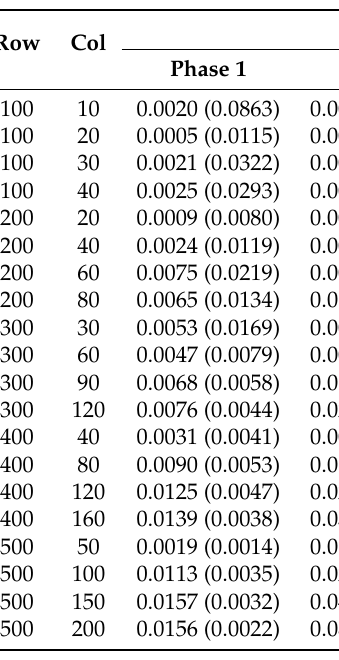
Table 1. The average wall-clock time of SAJS with (cid:101) =